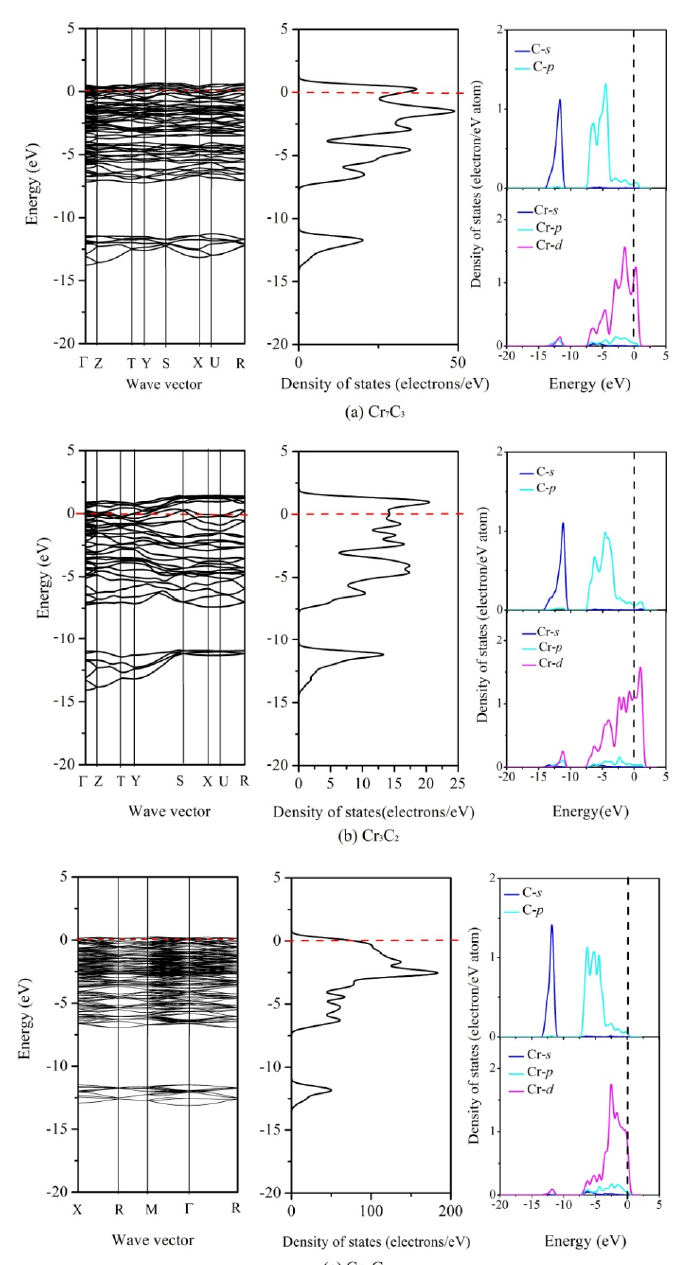
Figure 4. The total and partial density of states (DOS) of binary chromium carbides without applied